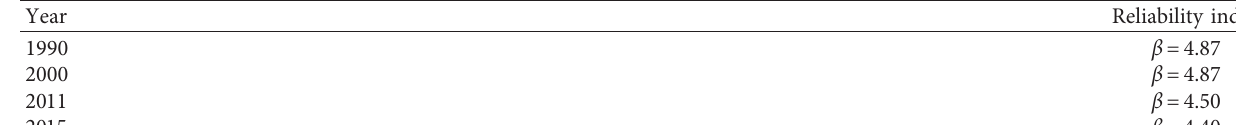
Table 7: Reliability value of the critical bar for each inspection